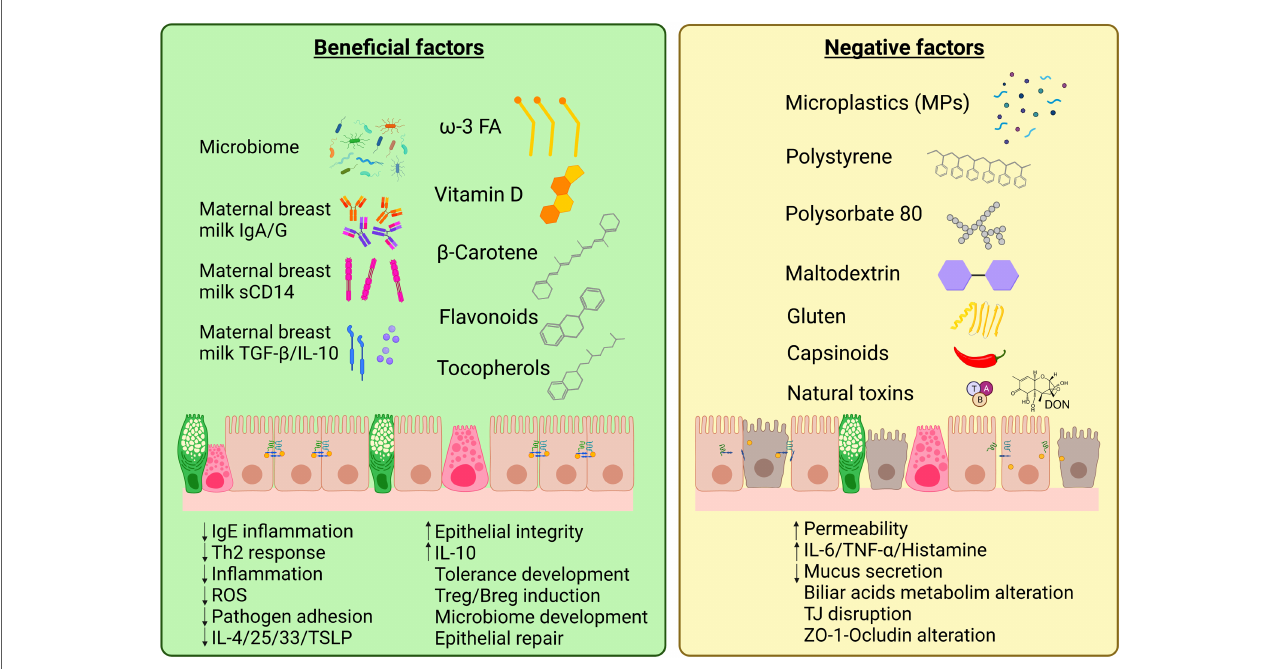
FIGURE 2 Diet components that present bene fi cial or negative effects on the intestinal epithelial barrier. An equilibrated diet and maternal breast milk contains a wide variety of bene fi cial factors that enhance intestinal epithelium integrity and repair. However, western lifestyle and pollution have introduced new agents in our diet that, together with natural compounds as gluten, capsinoids or natural toxins [e.g., mycotoxins as deoxynivanelol (DON)], can be irritant or present negative effects on gut epithelial cells increasing barrier permeability and potentially triggering allergic responses (Created with